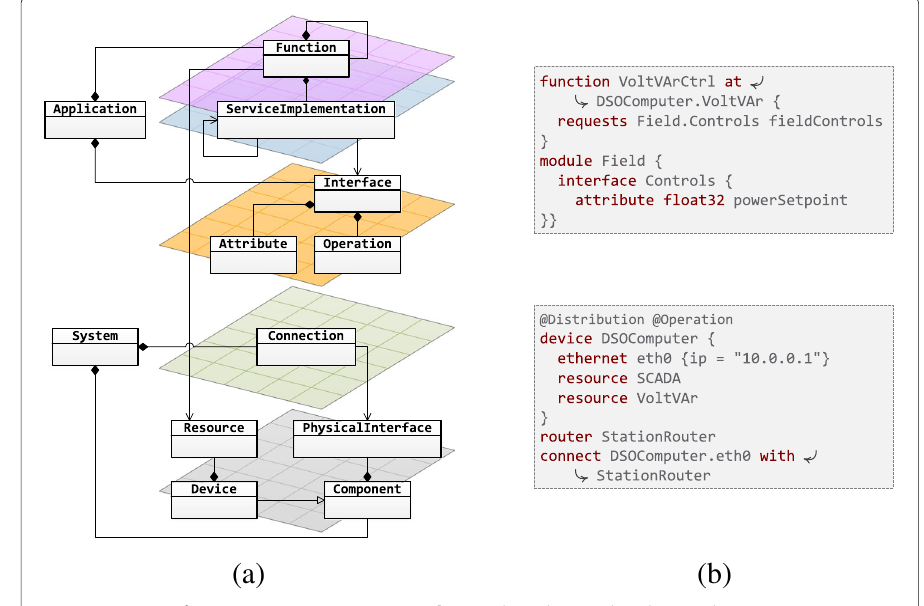
representation of PSAL’s metamodel as well as example implementations of an Applica- tion and a System are shown. One of the main ideas with PSAL is that it should allow rapid generation of code and configurations (Pröstl Andrén et al.